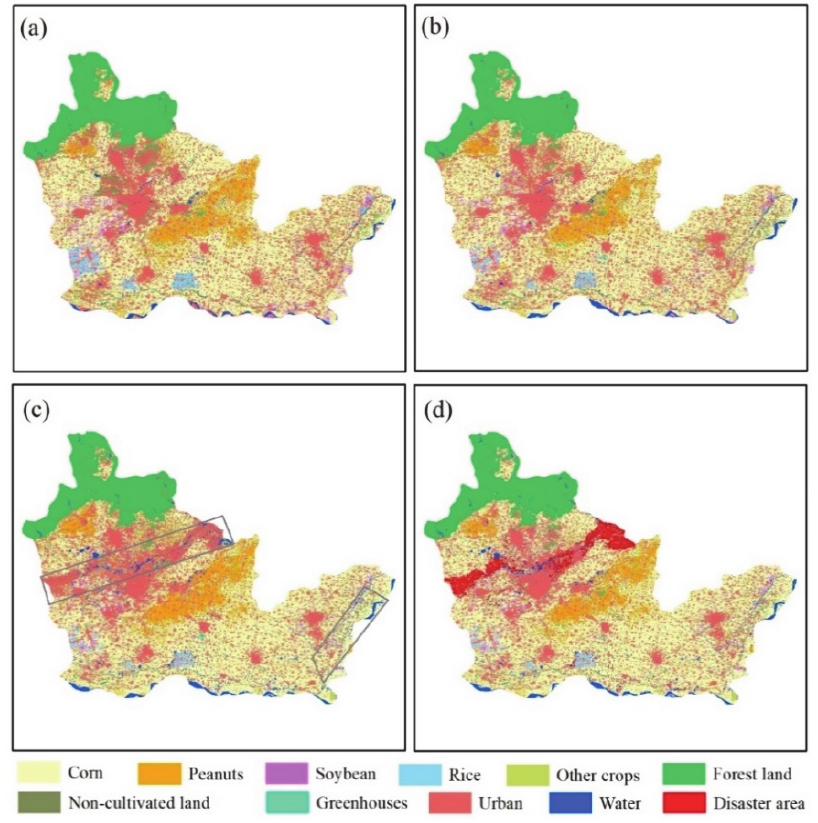
Figure 6. Segmentation and classification results of scheme 2 based on UNet++ model in 2019, 2020, and 2021. ( a ) Classification result in 2019; ( b ) classification result in 2020; ( c ) classification result in 2021; ( d ) reclassification result in